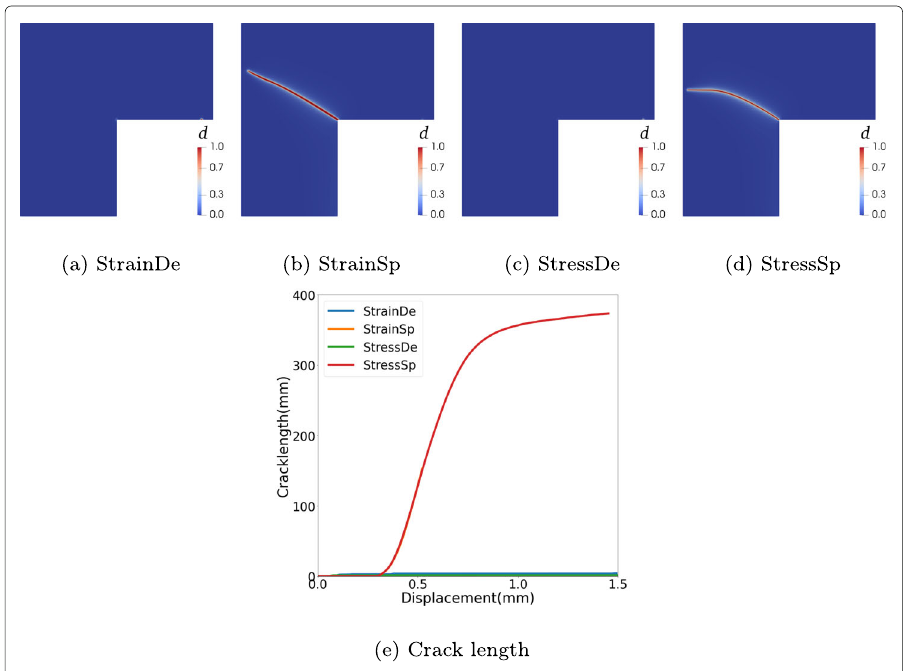
Fig. 13 Fracture results from the L-shaped panel simulations: ( a ) - ( d ) final crack paths for the strain deviatoric decomposition method, strain spectral method, stress deviatoric decomposition method, and stress spectral method, respectively; ( e ) the crack length evolution for the four methods